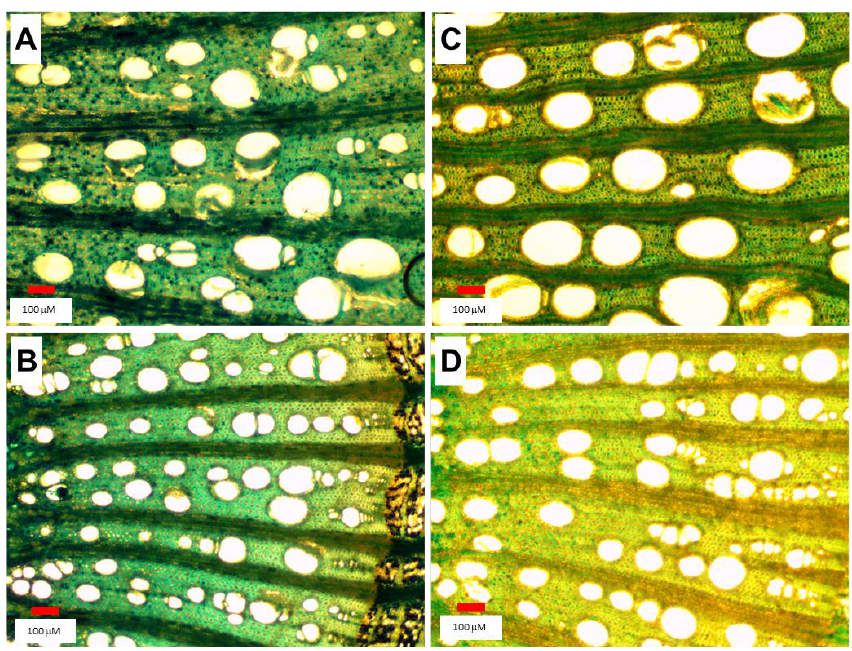
Figure 3. Representative cross-sections observed under the light microscope (4× magnification) for the ‘Sauvignon Blanc’ R2 ( A ), ‘Garofanata’ ( B ), ‘Nebbiolo’ ( C ) and ‘Montepulciano’ ( D ) cultivars. Scale bar, 100 μm. All pictures are displayed at the same magnificati on. Red-berried cultivars — Related to the mean of all vessel diameter measurements 178 from each grape cultivar, the ‘Nebbiolo’ showed the largest vessel diameter (152.9 μm), 179 followed by ‘Limberger’ (123.4 μm). Conversely , ‘Balsamina’ and ‘Montepulciano’ 180 showed the smallest diameters, at 75.4 µm and 70.6 µm, respectively. All of the other cul- 181 tivars showed intermediate diameters (Figure 4).